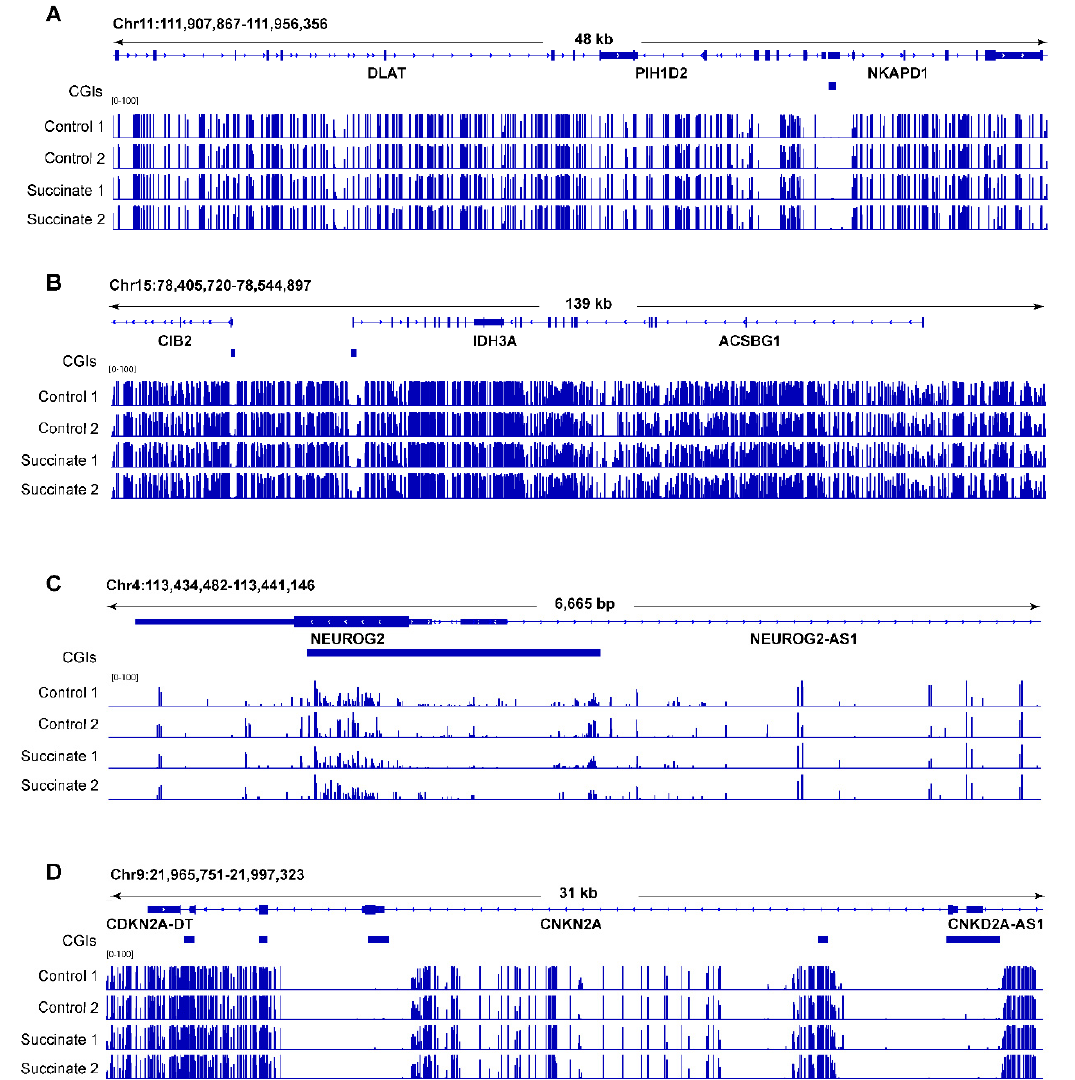
Figure 3. Examples of whole-genome bisulfite sequencing of control and succinate-treated bronchial epithelial cells. ( A ) A locus on chromosome 11 including the DLAT , PIH1D2 , and NKAPD1 genes; ( B ) a locus on chromosome 15 including the CIB2 , IDH3A , and ACSBG1 genes; ( C ) the NEUROG2 locus on chromosome 4; ( D ) the CDKN2A locus on chromosome 9. Blue horizontal bars below the genes represent CpG islands